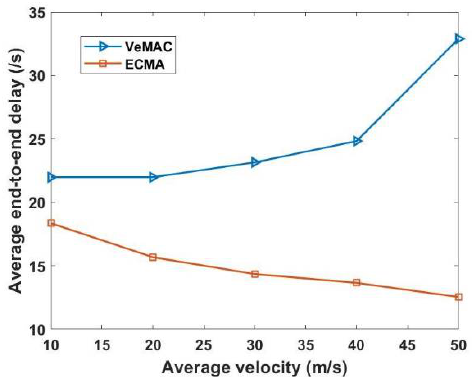
Figure 10. Average end-to-end delay versus average velocity.